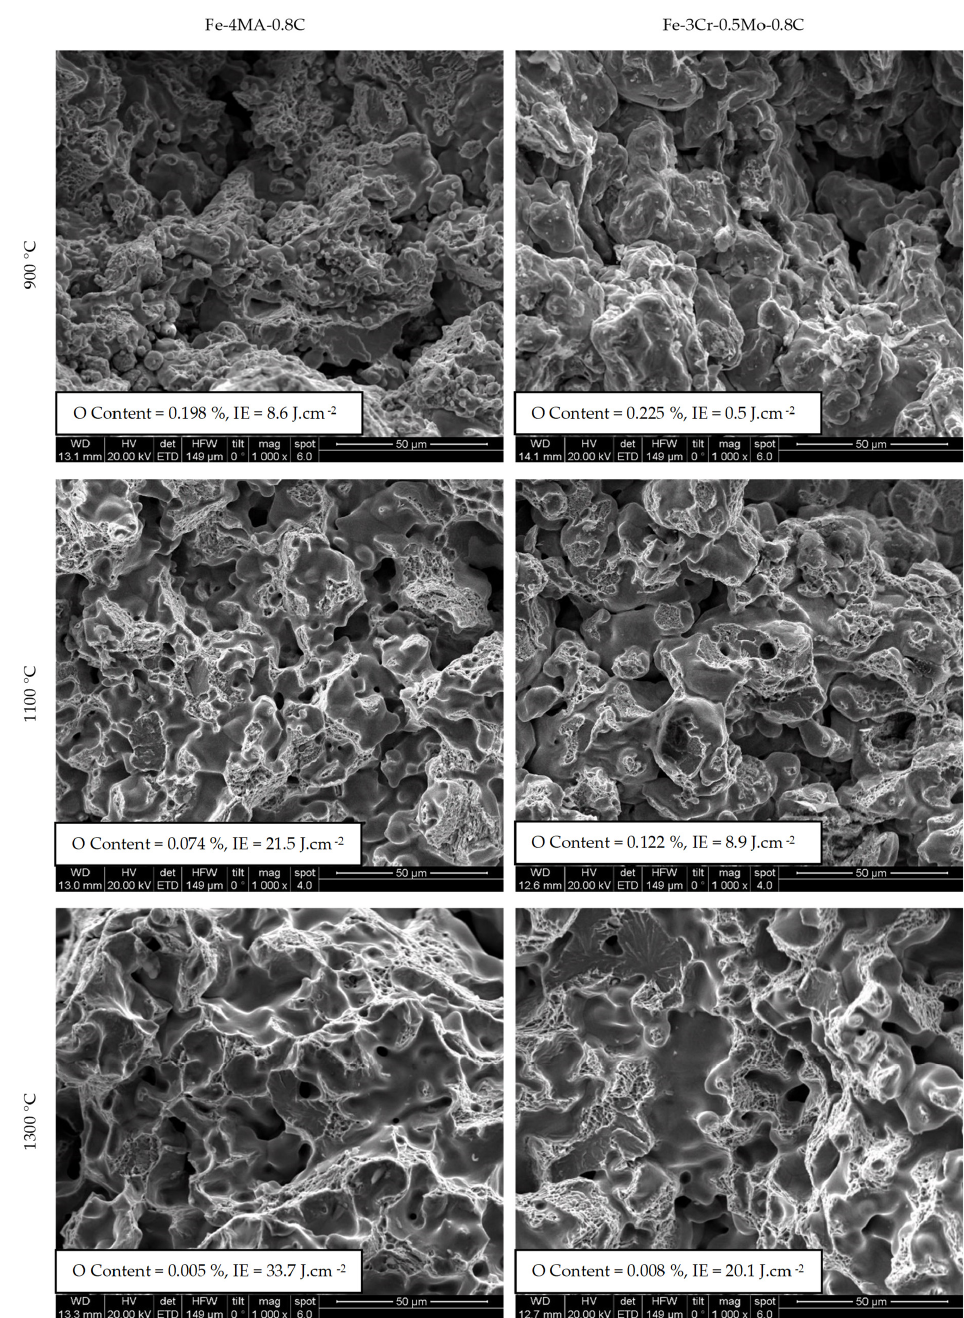
Figure 6. Effect of sintering temperature on the morphology of the interparticle necks and fracture Figure 1000×.